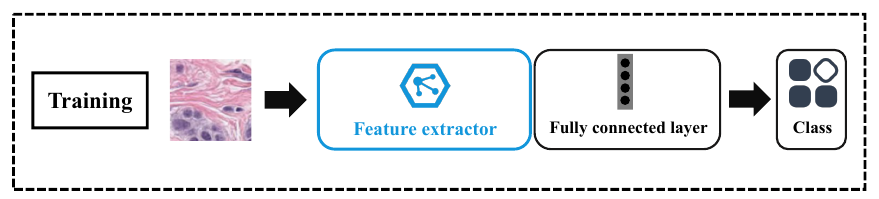
Figure 1. Training stage of our method. Our method follows the classical routine of training a classifier during